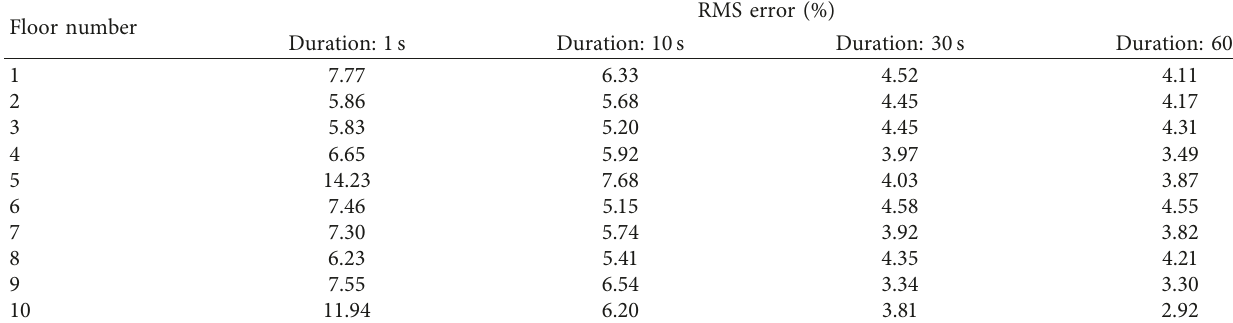
Table 4: RMS errors of the estimated wind load under different sampling durations.